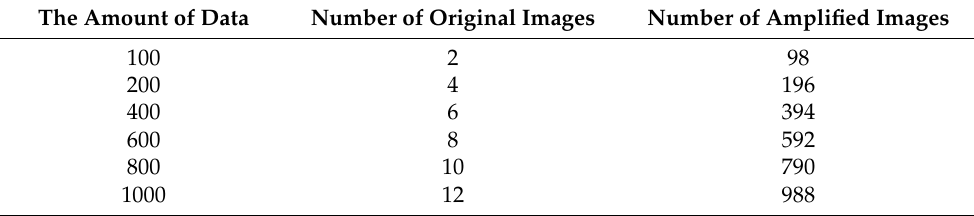
Table 1. Efficiency experiment data set selection.